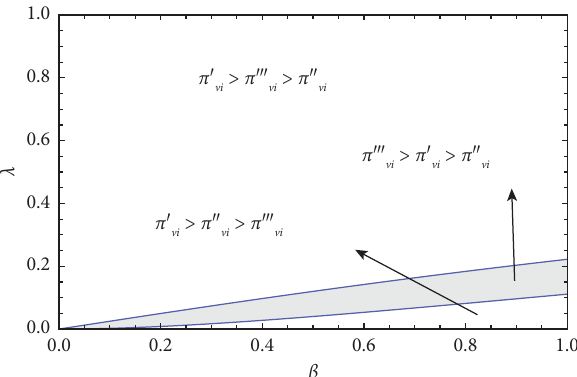
Figure 4: Equilibrium proft under centralized